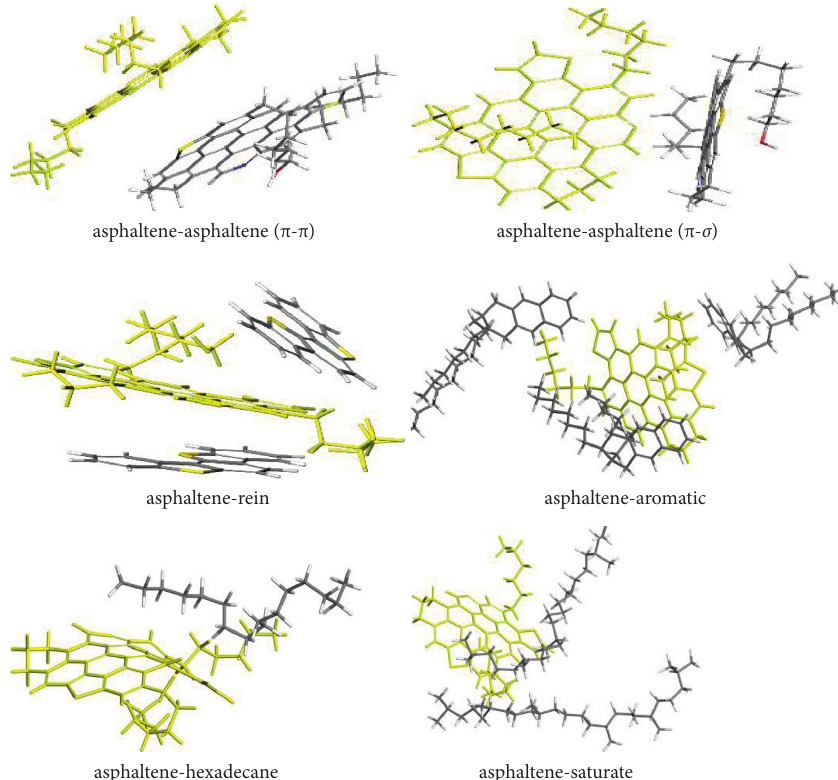
Figure 4: Morphology of asphaltene molecules with other fractions at 298K.